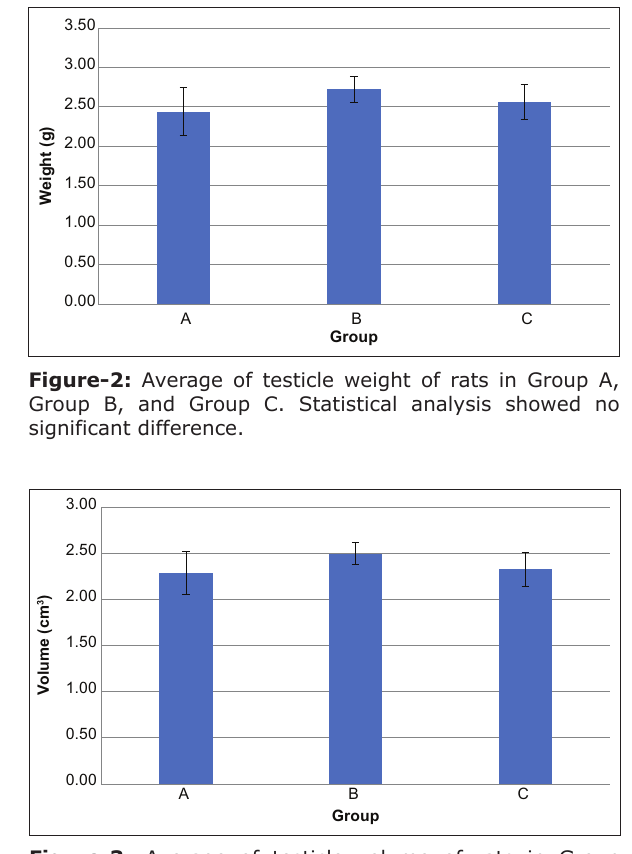
Figure-3: Average of testicle volume of rats in Group A, Group B, and Group C. Statistical analysis showed no significant